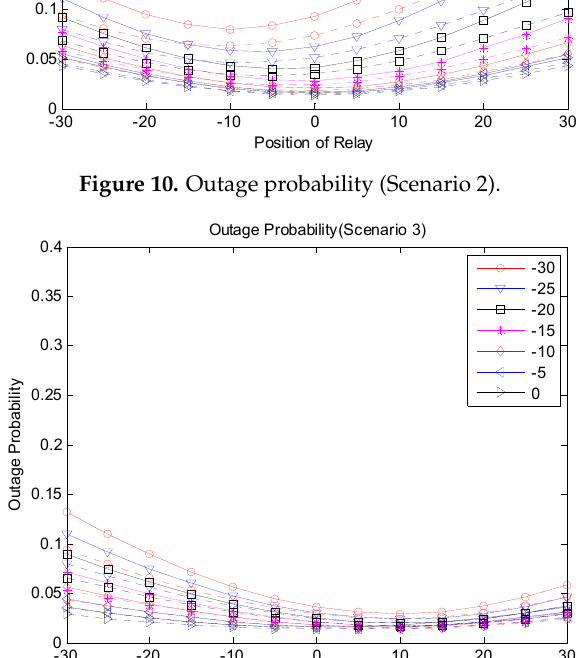
Figure 11. Outage probability (Scenario 3).